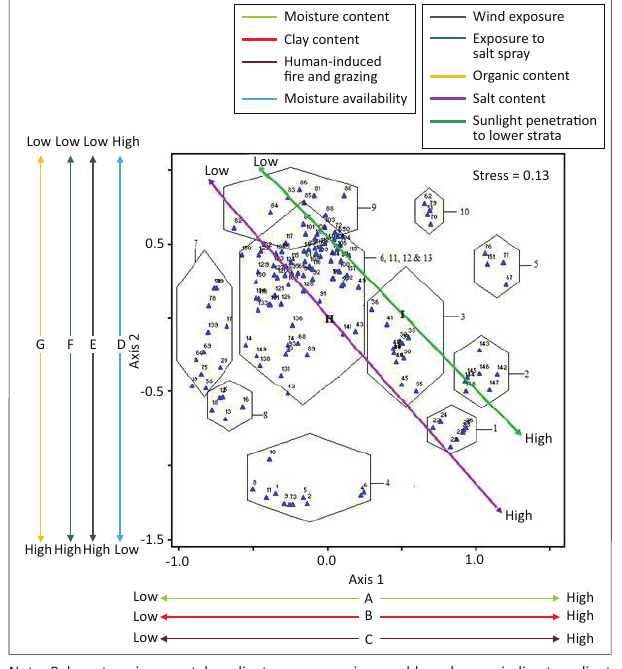
Note: Relevant environmental gradients were superimposed based on an indirect gradient analysis. Large and small font numbers correspond with plant community and relevé numbers, respectively, while alphabet letters indicate environmental gradients. FIGURE 2: Plant community clusters of the uMlalazi Nature Reserve as produced by a non-metric multidimensional scaling